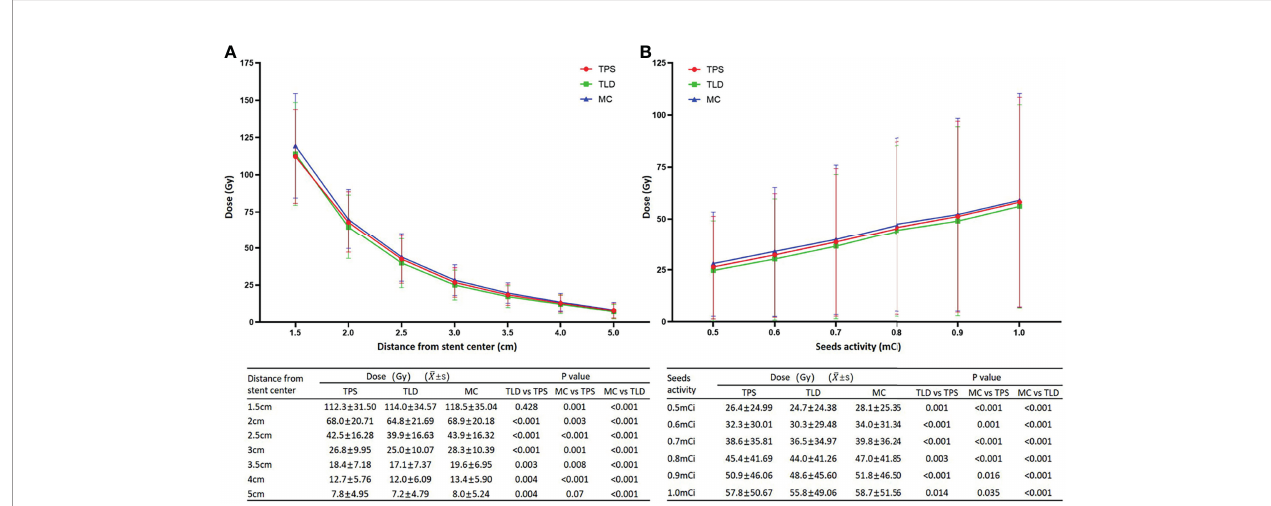
FIGURE 3 | (A) Although the dose at 1.5 cm measured by the TLD was not signi fi cantly different from that calculated by the TPS, at all other locations, the TLD measurements were signi fi cantly lower. Alternatively, while the dose at 5.0 cm simulated by MC was not signi fi cantly different to that calculated by the TPS, all of the other MC simulation results were signi fi cantly higher. When compared to the TLD measurements, MC simulations were consistently higher with signi fi cant differences. (B) Dose increased linearly with increasing activity. Doses from the MC simulations were the highest, followed by TPS calculations and TLD measurements, and the differences between the three methods were signi fi cant.